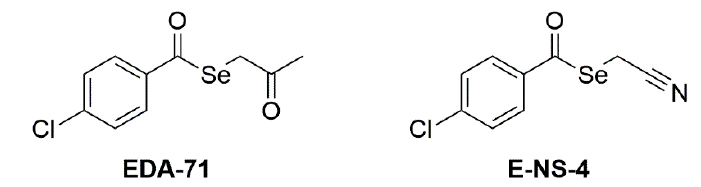
Figure 1. Structure of the tested